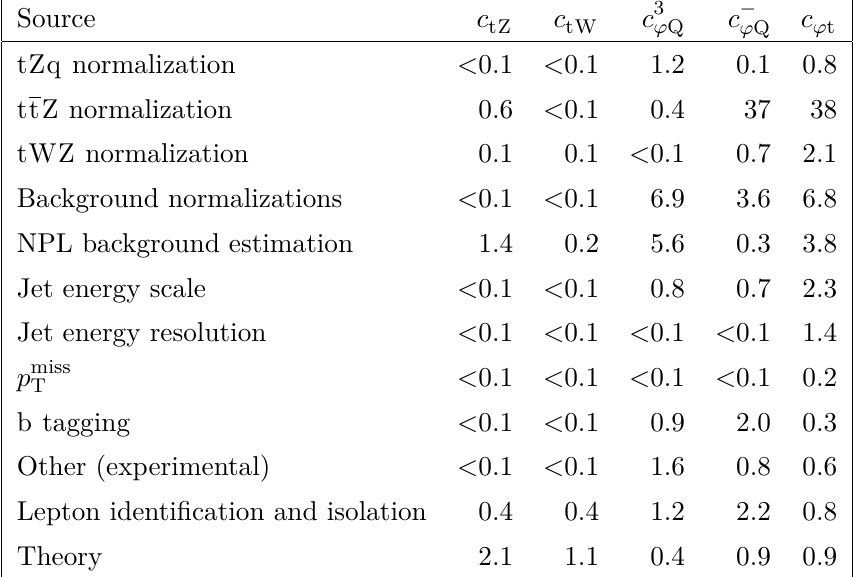
Table 7 . Impacts from different groups of sources of systematic uncertainty on each individual WC. To estimate the impact of a given group, the corresponding sources of systematic uncertainty are excluded, the 1D fits to the data are repeated, and the reduction in the width of the confidence interval is quoted for each WC. The values are given in